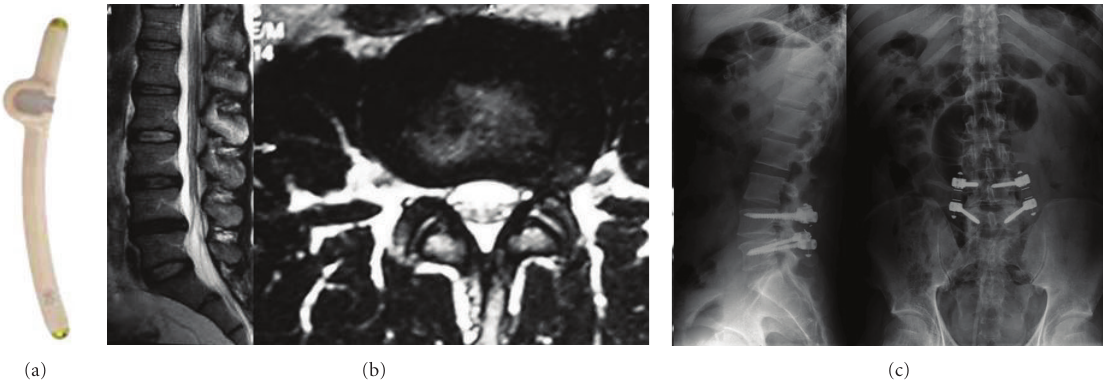
Figure 15: (a) BalanC rod. (b) 25-year-old male patient with severe back pain attacks every two months in last year. T2 weighted MRI scans show posterolateral annular rupture on the left side. (c) After repairing the posterior annulus under a microscope, dynamic screws (Cosmic screw) were used with dynamic rods (BalanC). The patient was very well 6 months after the of operation.